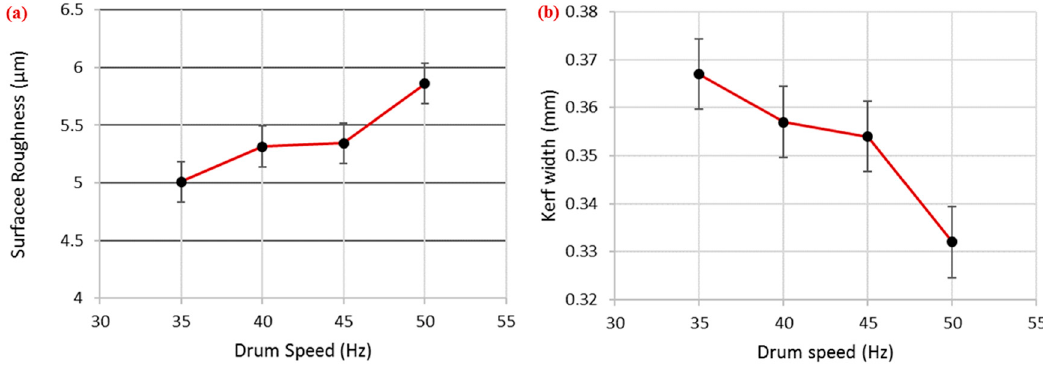
Figure 8. Effect of drum speed on ( a ) surface roughness and ( b ) kerf width. Figure 8. E ff ect of drum speed on ( a ) surface roughness and ( b ) kerf